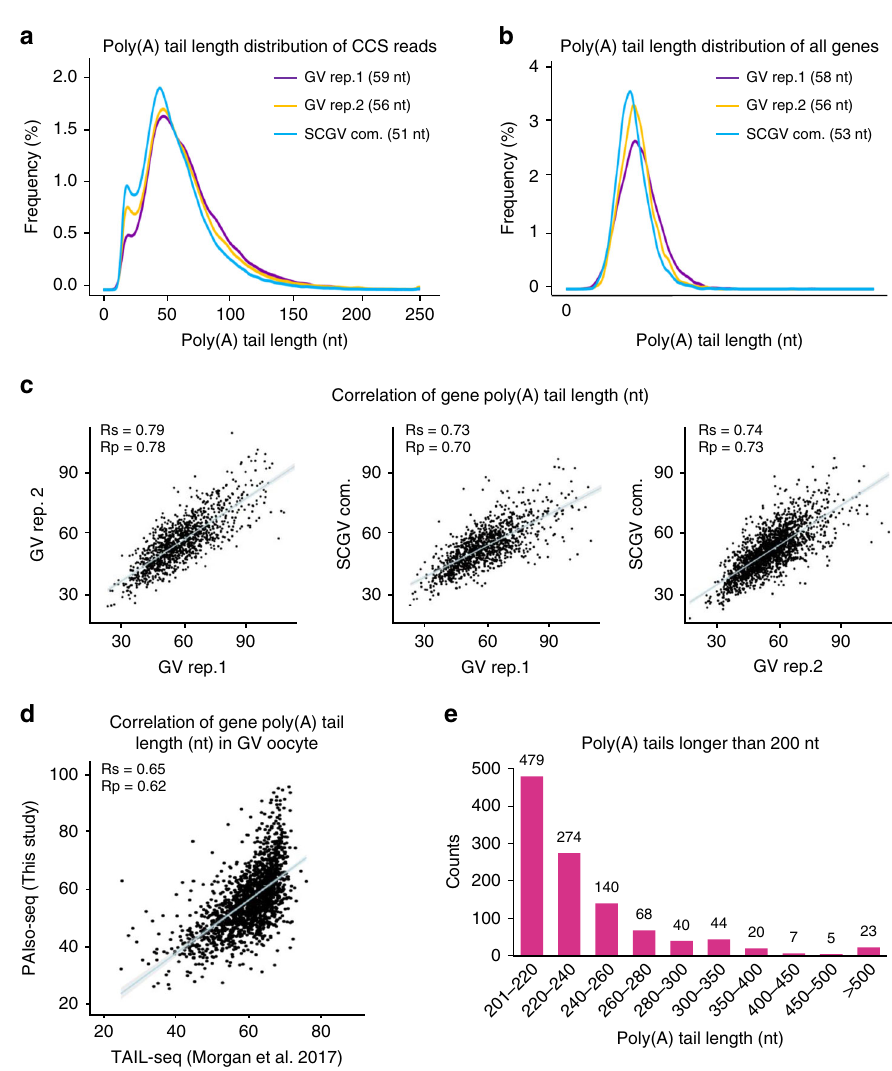
Fig. 2 PAIso − seq captures poly(A) inclusive transcripts. a Global distribution of poly(A) tail lengths of all transcripts (CCSs) in GV oocytes. The median poly(A) tail length of CCS reads for each replicate is shown. b The distribution of poly(A) tail lengths of all genes. The median of mean poly(A) tail length of the genes for each replicate (with no less than three CCSs) is shown. c The correlation of gene (with no less than ten CCSs in each of the replicates) poly (A) tail length among three replicates of GV oocytes. The blue line represents linear regression line. The light-gray area represents con fi dence interval of the regression. n = 1179 (left panel), n = 1120 (middle panel), and n = 1992 (right panel). R p and R s refer to Pearson ’ s and Spearman ’ s correlation coef fi cient. d The correlation between gene poly(A) tail length in GV oocytes measured by PAIso − seq (this study) and TAIL-seq 10 . The blue line represents linear regression line. The light-gray area represents con fi dence interval of the regression. Genes with at least 10 reads in PAIso − seq and 30 tags in TAIL-seq datasets are included in the analysis ( n = 1662). R p and R s refer to Pearson ’ s and Spearman ’ s correlation coef fi cient. e The distribution of poly(A) tails longer than 200 nt. The number above the bar shows the counts of CCS reads with given poly(A) tail